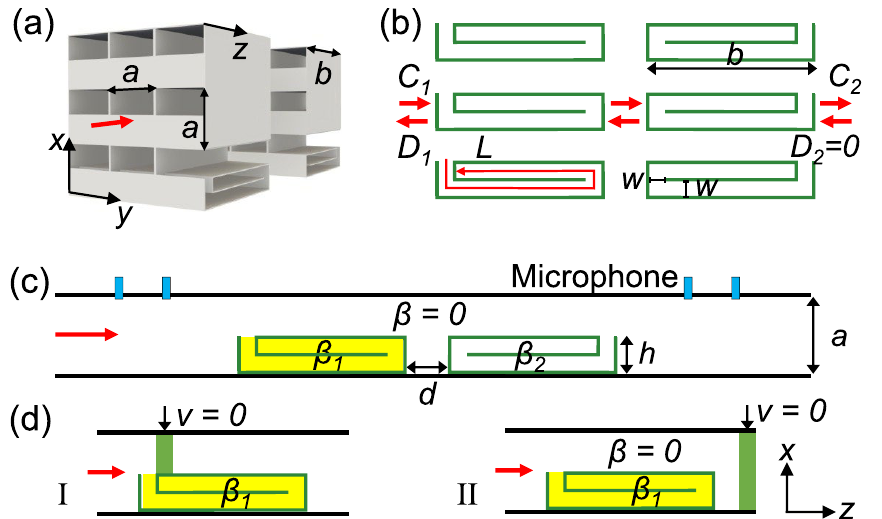
Figure 1. Schematic of the bilayer ventilated labyrinthine metasurface and experimental setup. ( a ) 3D and ( b ) side views of the bilayer labyrinthine metasurface that is immersed in air and impinged by a sound plane wave from the left. To illustrate the inner structure, two side plates are removed in ( a ). ( c ) Schematic side view of the experimental setup for acoustic absorption measurements. Here, a unit cell of the bilayer metasurface, consisting of two curled channels with sound loss β 1 and β 2 inside, is placed in an acoustic impedance tube. ( d ) Simplified models for cases with perfect absorption (I) and incomplete absorption